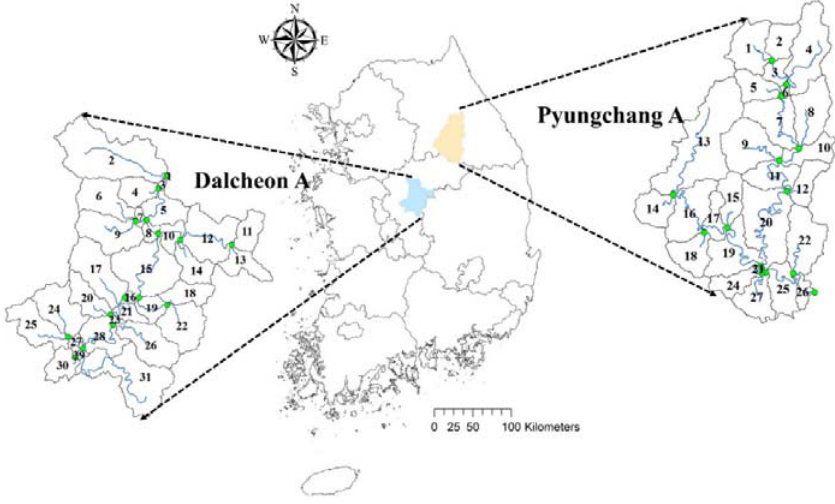
Figure 2. Two study watersheds used for evaluation of watershed ‐ scale L ‐ THIA ACN ‐ WQ model. Figure 3. Two study watersheds used for evaluation of watershed-scale L-THIA ACN-WQ model.